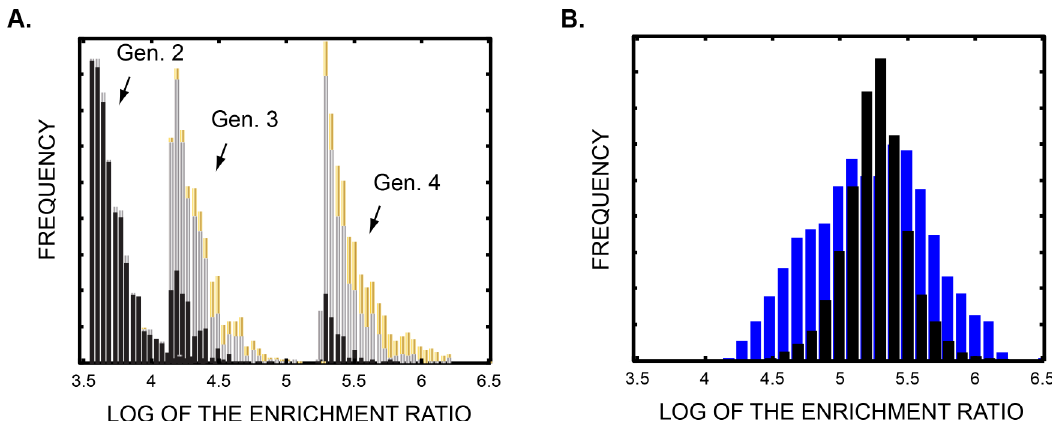
Fig 4. Population maturation. A. The peptide-DNA conjugate library converged to PKA substrates over four generations. A histogram of the fold-enrichment ratios for the top 1000 genes in generations 2 – 4 is shown. Genes lacking a consensus motif are colored black, genes that encoded peptides with one of the two PKA consensus motifs (RR * [S/T] * or RRSF * ) are colored silver, and genes that encoded the top RRSFL peptide are colored gold. See also S4 Fig. B . The DNA sequence of genes with synonymous codon substitutions influenced the enrichment of peptide-DNA conjugates. A histogram plot with blue bars shows the observed distribution of log fold-enrichment ratios for 830 different genes that encoded the same RRFSL peptide (95% are contained between 4.4 and 6). If all of the RRSFL-encoding genes had been equally enriched, the black distribution would have been expected (this computed distribution reflects Poisson noise from sparse gene sampling). The excess width of the observed distribution suggests the existence of a selection bias for or against different synonymous codons. The Poisson distribution was reduced to 0.63 of its full area for clarity of the